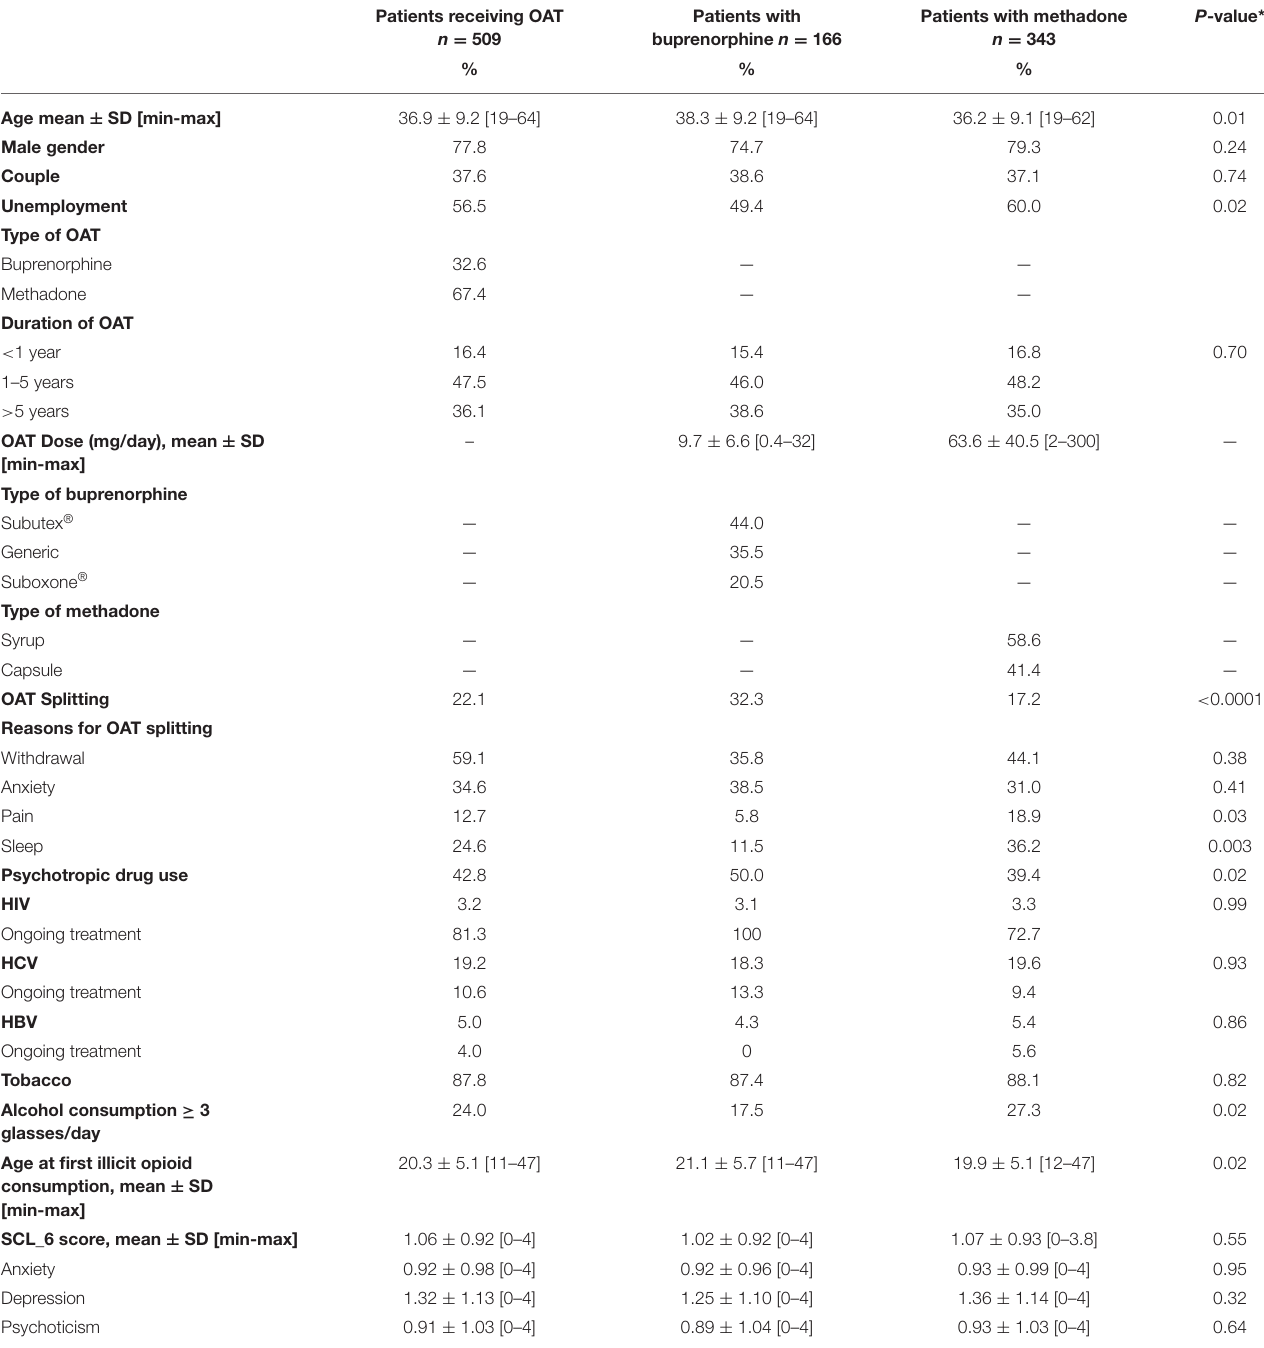
TABLE 1 | General characteristics of patients receiving OAT.